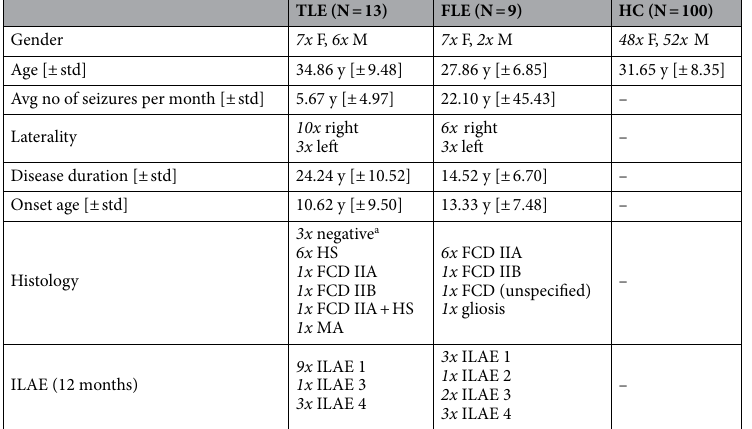
Table 1. Demographic and clinical summary of a patient group. M, male; F, female; TLE, temporal lobe epilepsy; FLE, frontal lobe epilepsy; HC, healthy control; FCD, focal cortical dysplasia; HS, hippocampal sclerosis; y, years; MA, meningioangiomatosis. a Patients with negative histological findings were included only if they achieved ILAE outcome ≤